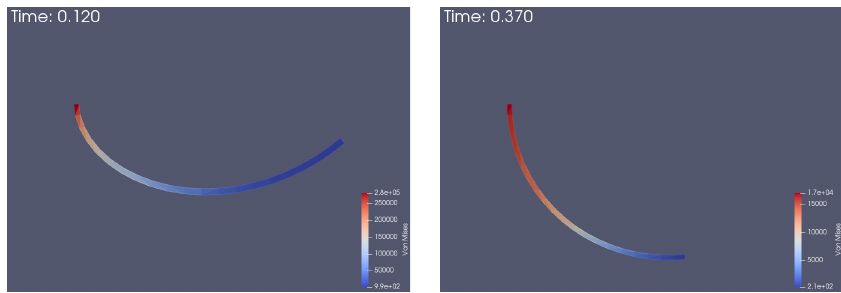
Figure 11. Von Mises stress distribution in the structure V max = 50.